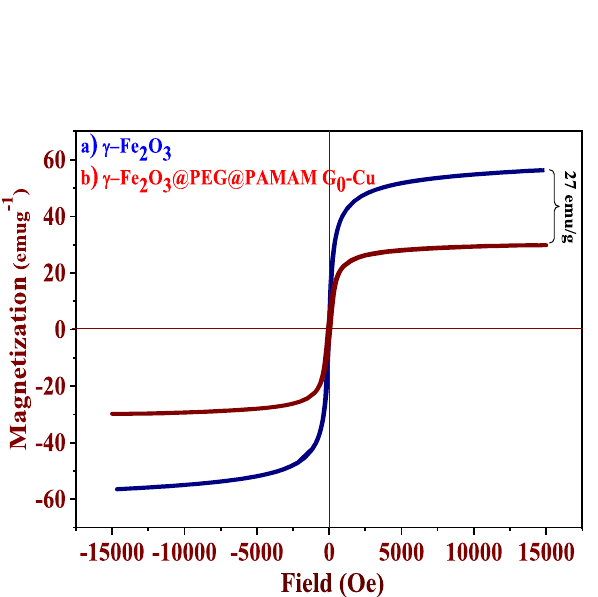
Figure 12. Magnetization curves of ( a ) γ-Fe 2 O 3 , ( b ) γ-Fe 2 O 3 @PEG@PAMAM G 0 -Cu at 300